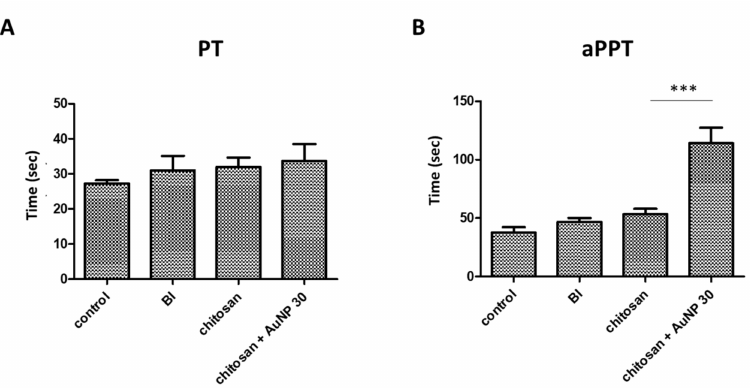
Figure 5. The effects of treatments on ( A ) prothrombin time (PT) and ( B ) activated partial thrombo- plastin time (aPTT). BI = lesion control group; *** p < 0.001.